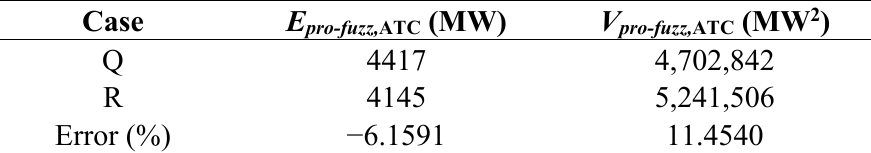
Table 13. The results of Case Q and Case